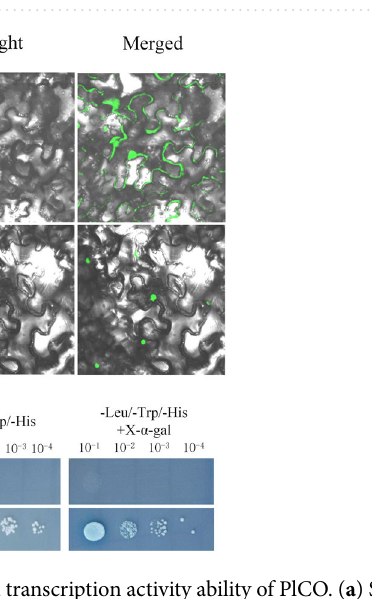
Figure 6. Flowering phenotype of PlCO over-expression in transgenic Arabidopsis plants. ( a ) The flowering phenotype of wild type and three trans-gene plants. WT, wild type; #1, #2 and #3 represent three lines of the PlCO over-expression transgenic plants. ( b ) The expression of PlCO gene in WT, #1, #2 and #3 transgenic plants. ( c ) The flowering time of transgenic Arabidopsis was less than WT. *p-value < 0.05. ( d ) The number of leaves at first flowering of WT and transgenic Arabidopsis. *p-value < 0.05.